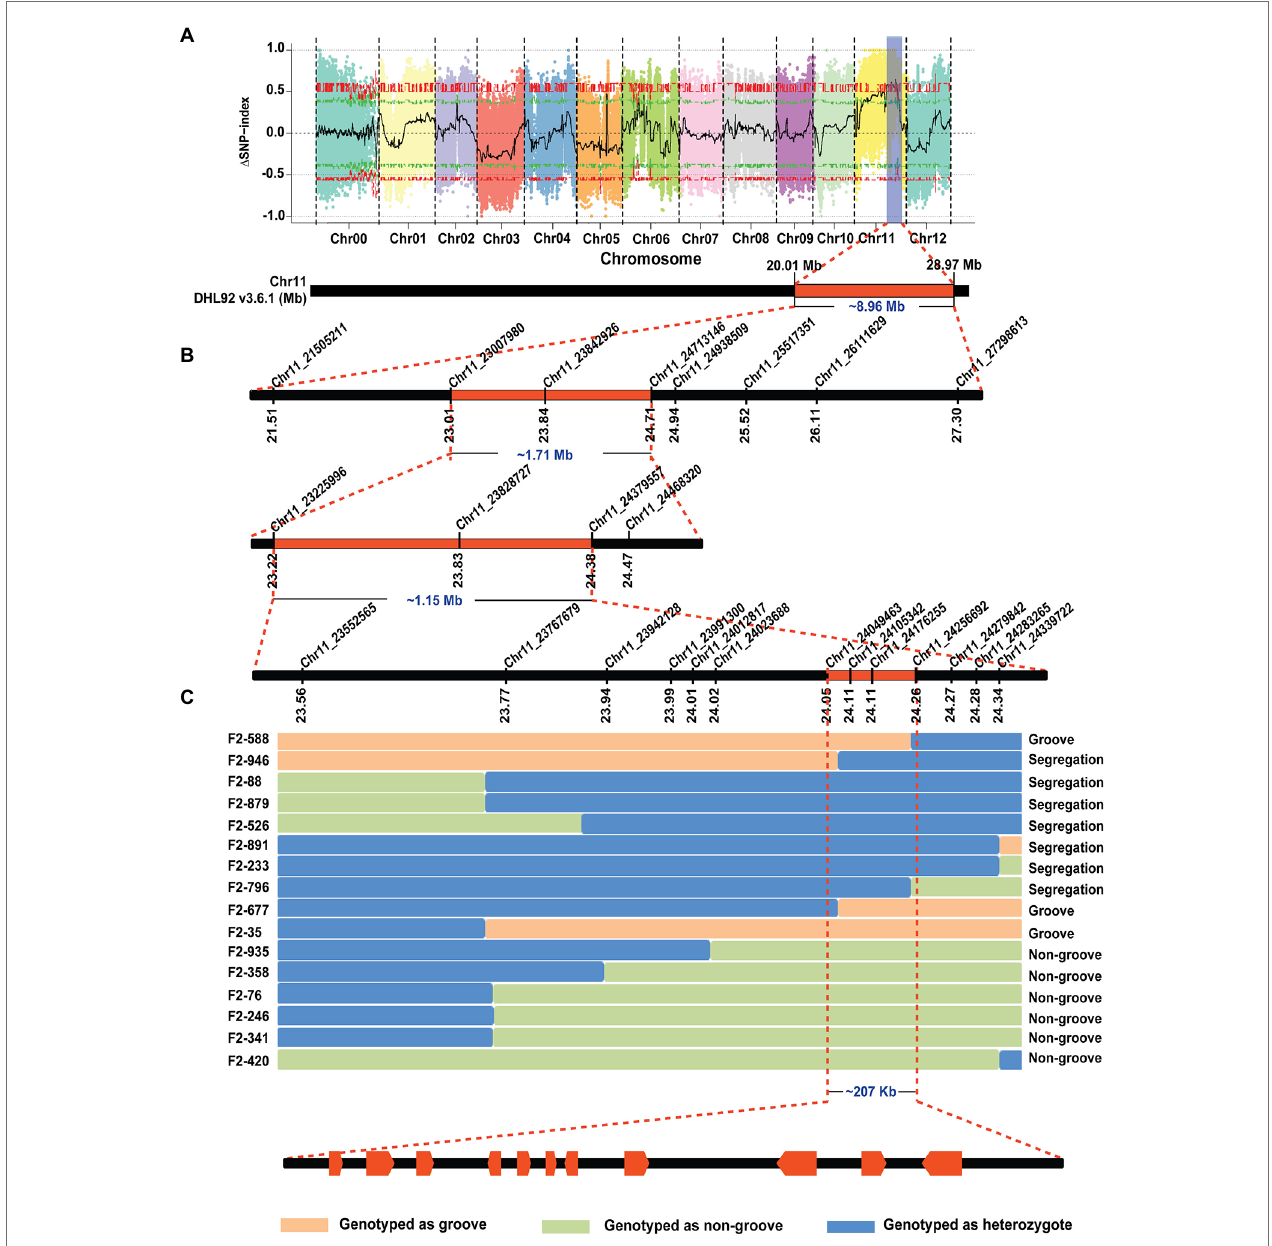
FIGURE 2 | BSA-seq analysis and fine mapping of the melon fsg trait. (A) BSA-seq results, the chromosome region related to the fsg trait, (B) initial mapping of the fsg trait. (C) Fine mapping of the fsg